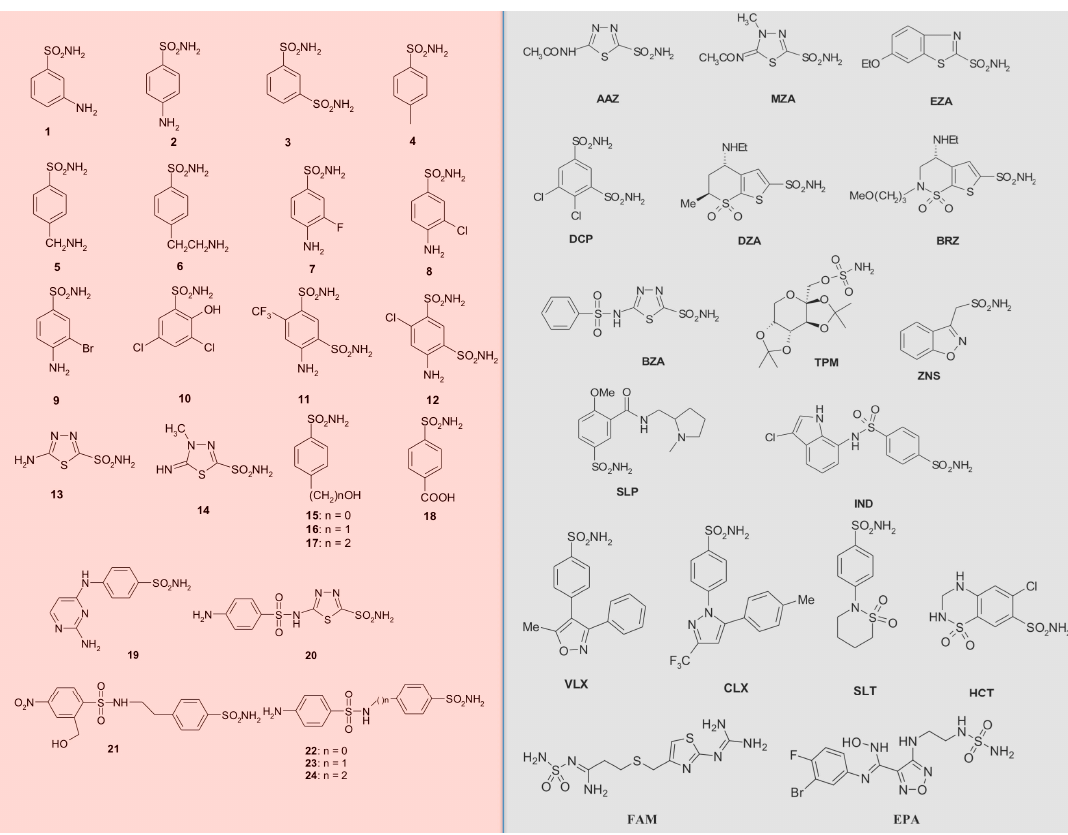
Figure 3. The 42 compounds used to study CynT2 inhibitory behavior. Forty-one sulfonamides and one sulfamate (TPM) were exploited. In red, the series 1 – 24 ; in gray, the clinically used drugs. Table 2. Inhibitor name, commercial name, acronym, and clinical treatment of the CAI clinically used drugs.